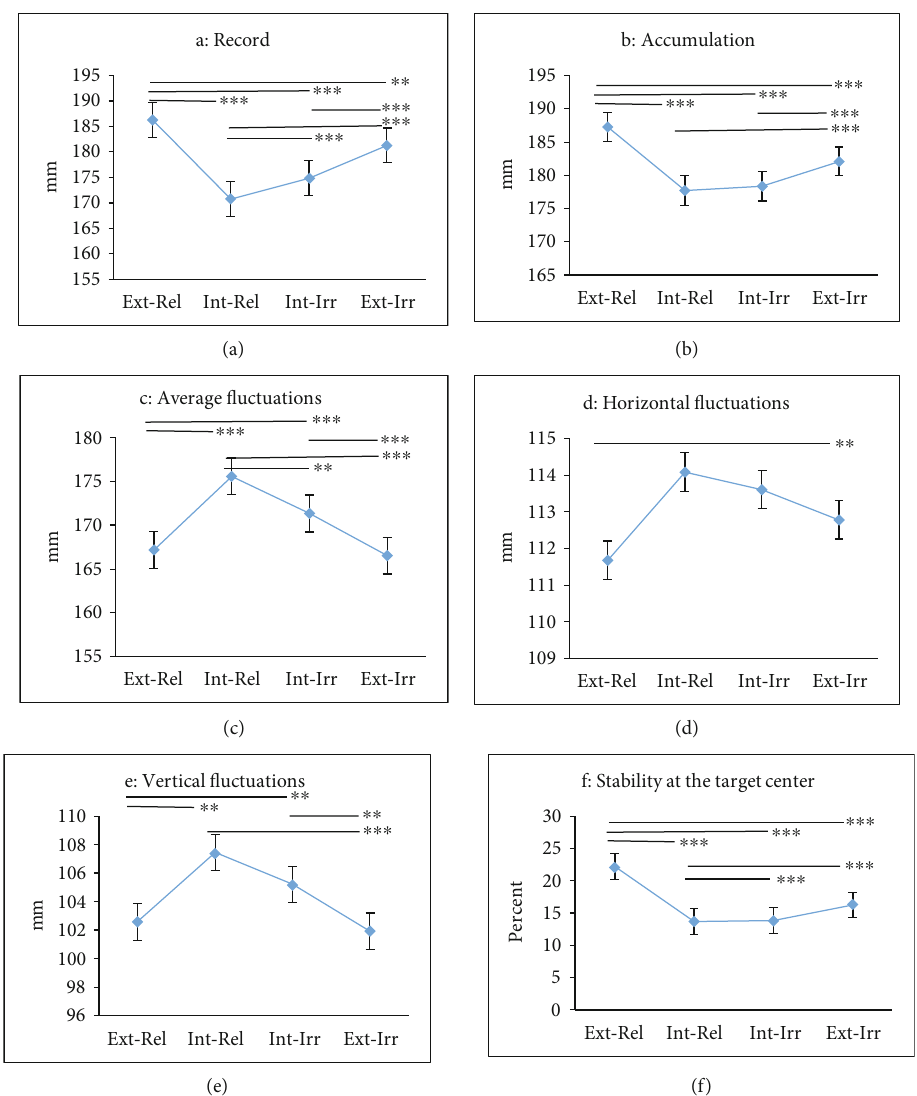
Figure 2: The e ff ects of four types of attentional focus strategies [(1) external-relevant, (2) internal-relevant, (3) internal-irrelevant, and (4) external-irrelevant] on some performance indicators of military elite shooters [(a) record, (b) accumulation, (c) average fl uctuations, (d) horizontal fl uctuations, (e) vertical fl uctuations, and (f) stability at the target center]. There is a signi fi cant di ff erence in external-relevant strategy performance to other strategies in the three indexes record, accumulation, and stability at the target center ( ∗∗∗ Signi fi cance level P ≤ 0 : 001